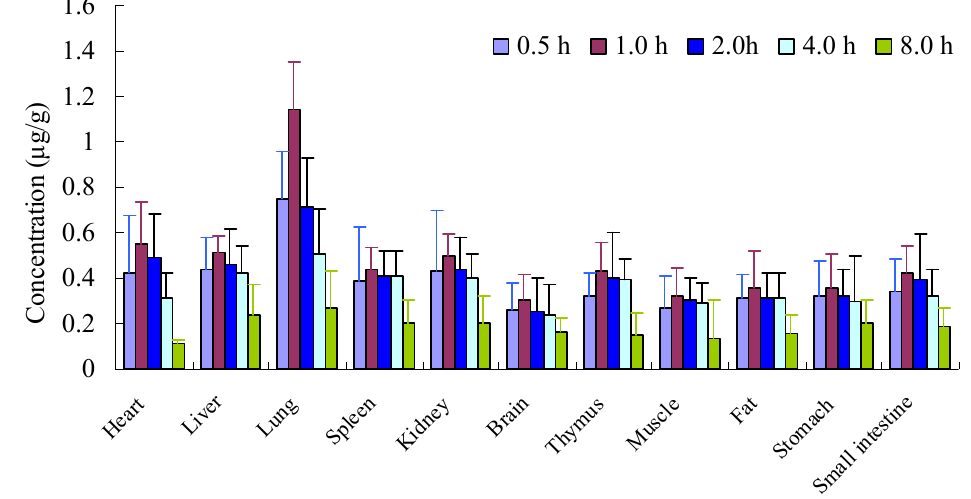
Figure 4. Tissue distribution of PD at times 0.5, 1.0, 2.0, 4.0 and 8.0 h after i.v. injection of 20 mg/kg in rats ( n =